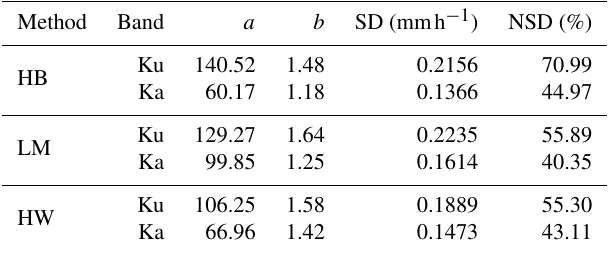
Table 3. Coefficients and exponents of the power-law Z –SR rela- tionship for HB, LM, and HW methods and Ku- and Ka-bands, re- spectively.